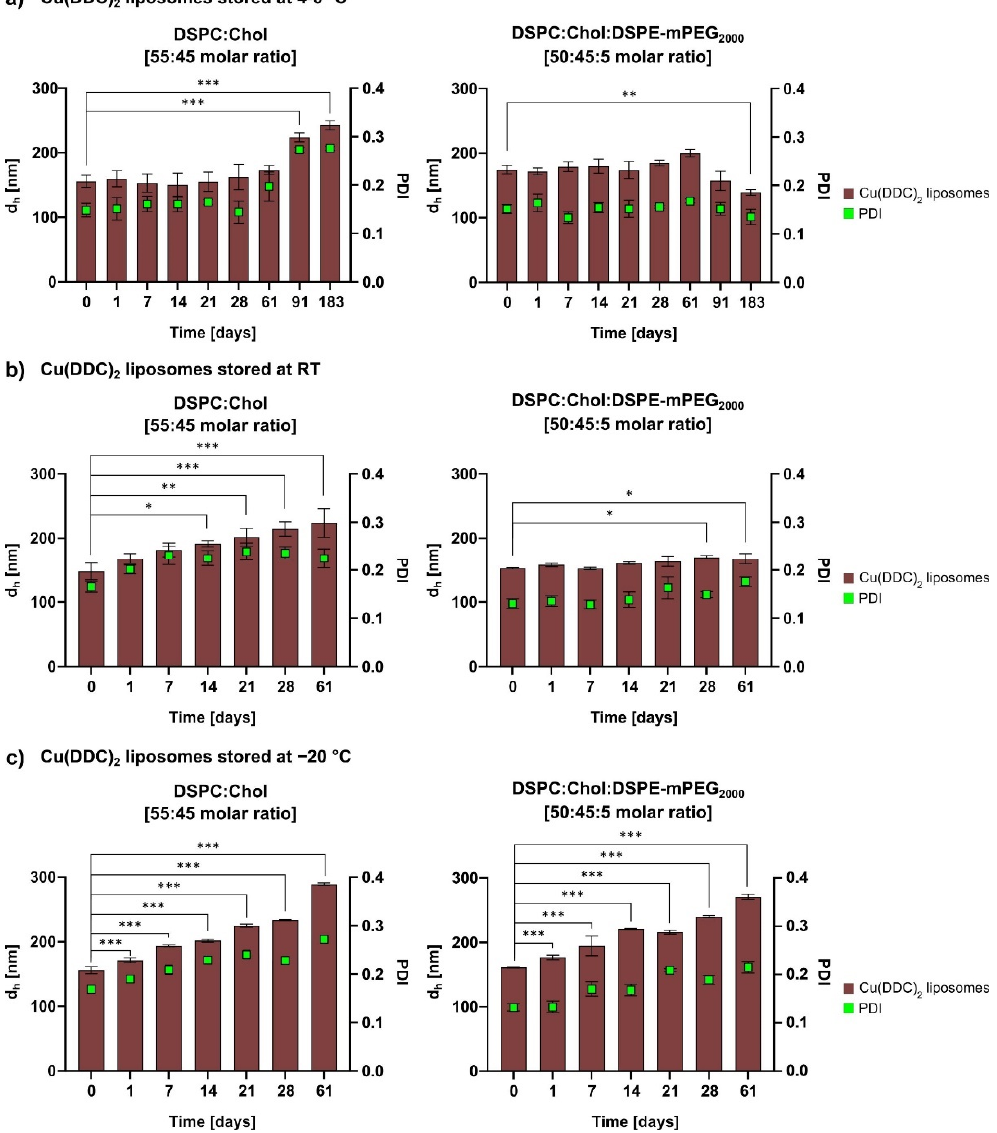
Figure 3. Colloidal stability analysis of Cu(DDC) 2 liposomes after different storage conditions. Aliquots of non-PEGylated and PEGylated Cu(DDC) 2 liposomes were analyzed via dynamic light scattering (DLS) over 6 months (183 days) at 4–6 ◦ C ( a ) and over 2 months (61 days) at RT ( b ) and − 20 ◦ C ( c ). Significant differences were evaluated via one-way ANOVA and Dunnett’s post-hoc test (* p ≤ 0.05; ** p ≤ 0.01; *** p ≤ 0.001). Data are expressed as the mean ± SD ( n =